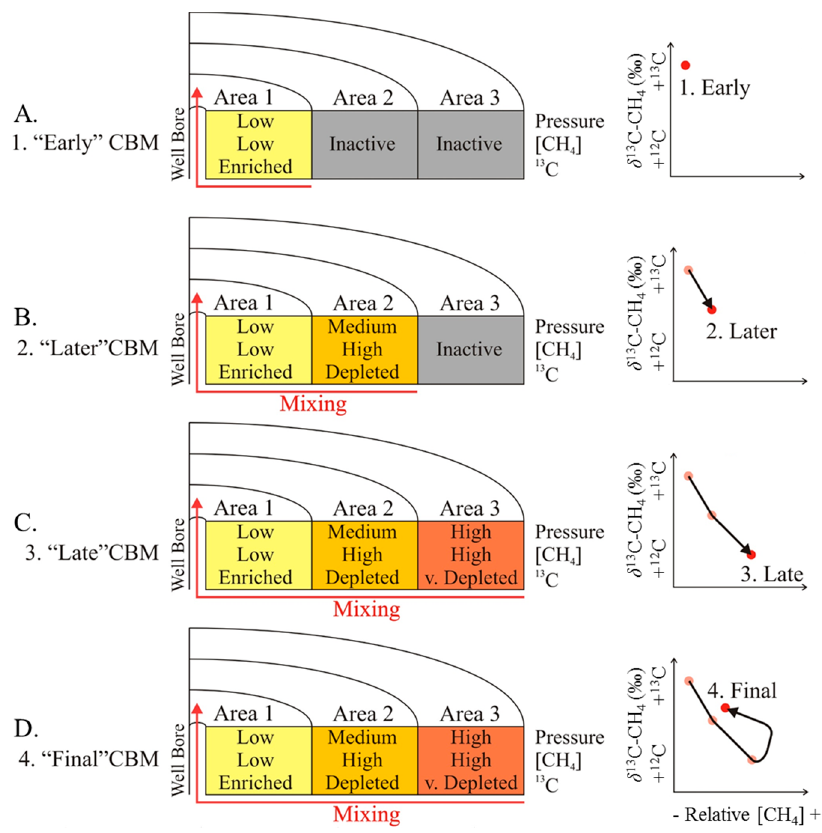
Figure 8. Idealized model for isotope and compositional development of methane during the production of CBM. Actual distances of Sections 1–3 are not known, and should differ strongly between different coal seams. See text for discussion.